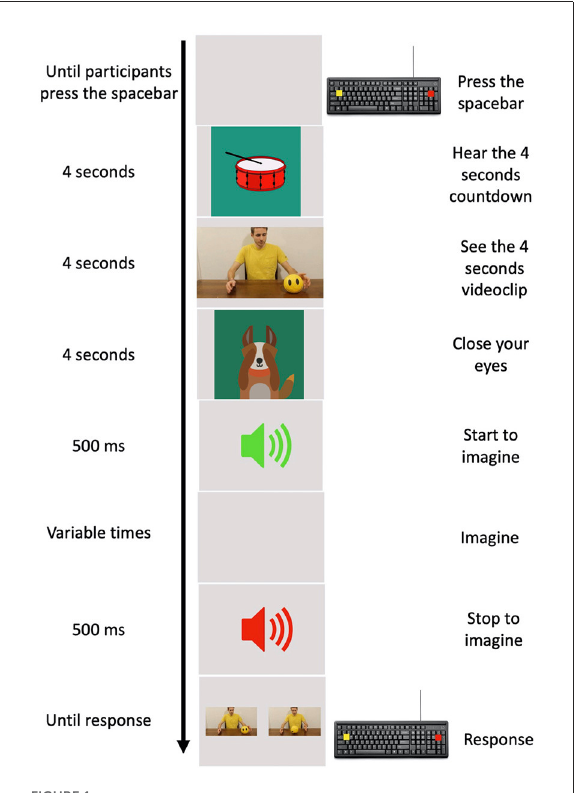
FIGURE1 Experimental procedure. In the left column, the time of each event is reported. In the middle column, a pictorial example of the events is depicted. In the right column, the action requested by participants to provide their responses is reported.